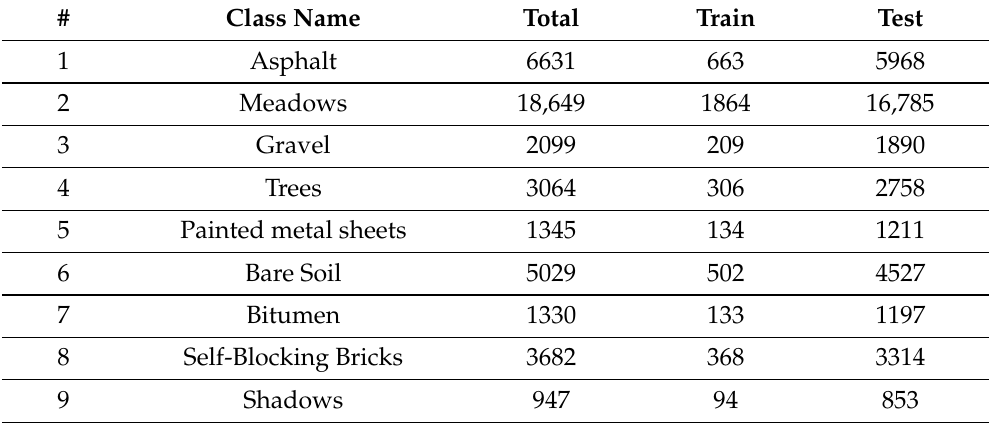
Table 4. Number of train and test sample in the Pavia University dataset.